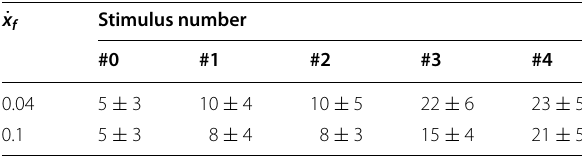
ing the contact period. Mean and standard deviation